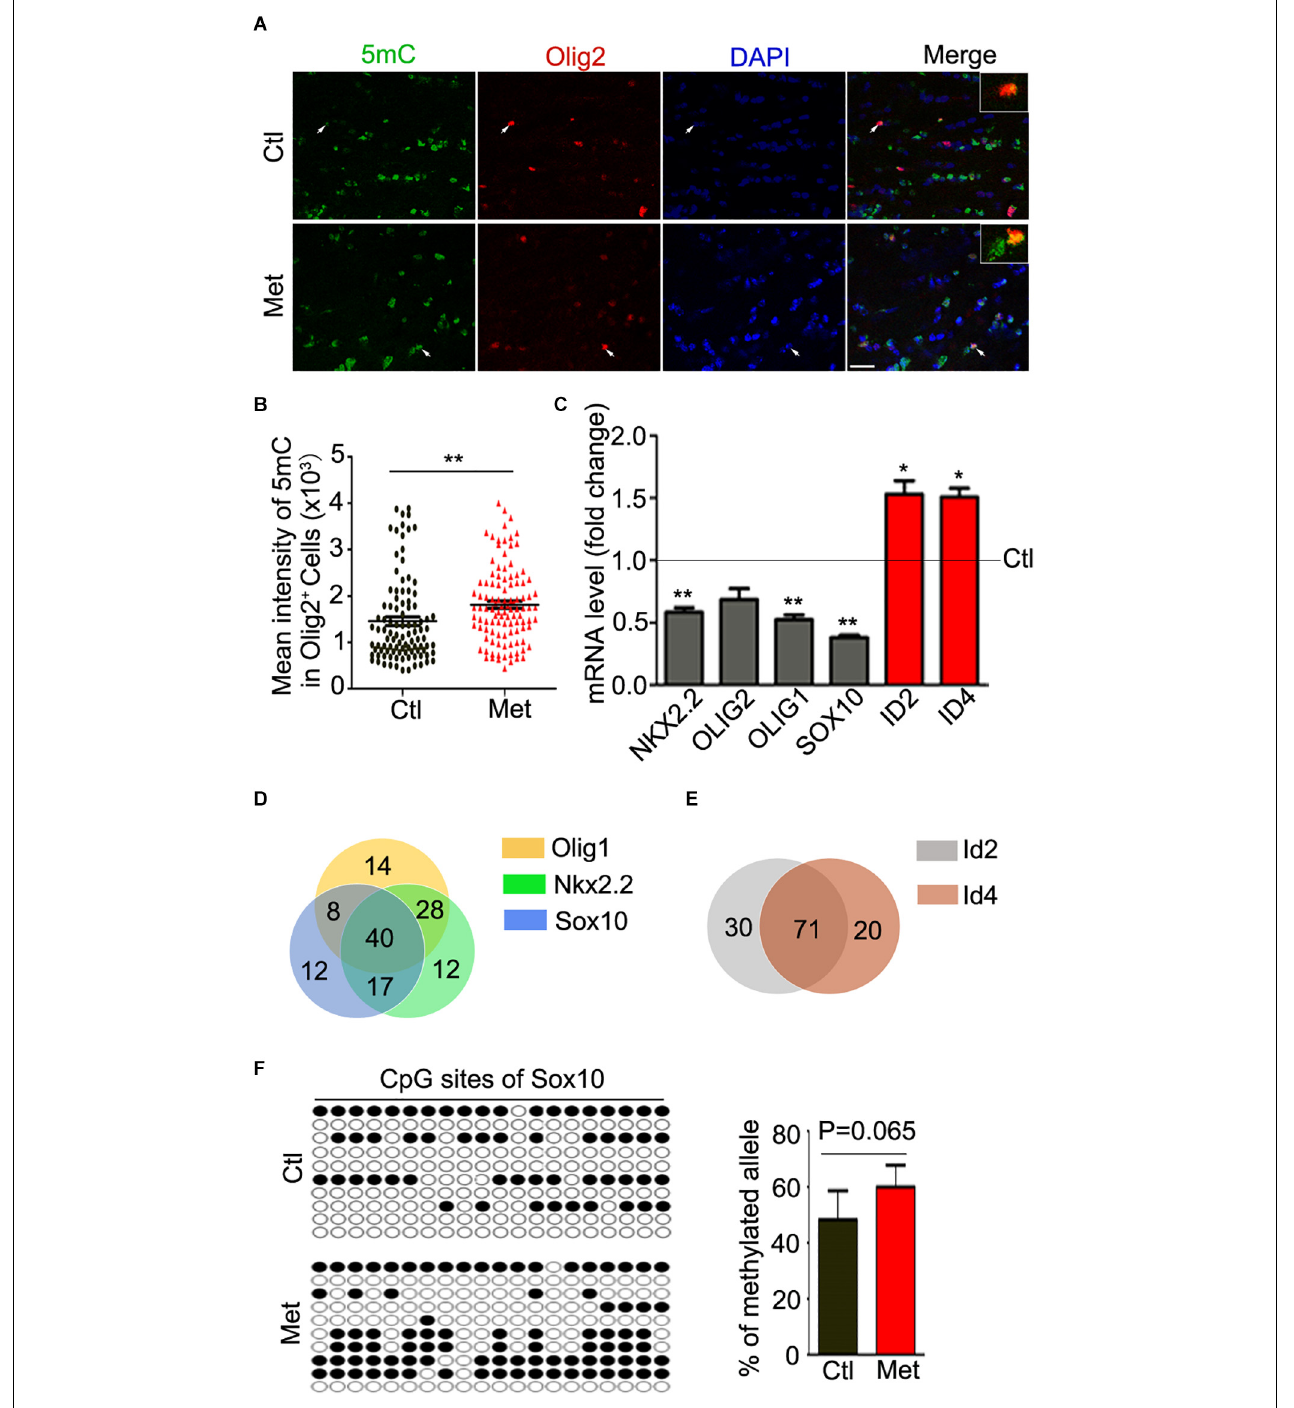
FIGURE 2 | Analysis of 5mC and gene expression in oligodendroglial lineage cells after Met treatment. (A) Representative images showing immunofluorescence staining of 5mC and Olig2 in the frontal white matter in mice. Ctl, vehicle-treated mice. Met, Met-treated mice. White arrows indicate representative 5 mC and Olig2 duoble-labling cells, which are enlarged in white rectangle. Scale bar = 20 µ m. (B) The bar graph shows the quantification of the mean intensity of 5mC in Olig2-staining cells ( n = 100 cells from 5 mice in the Ctl group, n = 109 cells from 5 mice in the Met group). (C) The graph shows the quantification of NKX2.2, OLIG2, OLIG1, SOX10, ID2, and ID4 transcript levels in the frontal white matter in Met mice, which were normalized to the transcript levels in Ctl mice (dashed line) ( n = 3 for each group). (D) The venn diagram shows the number of transcription factors predicted to bind to the promoters of Olig1 (yellow), Sox10 (blue), and Nkx2.2 (green). (E) The venn diagram shows the number of transcription factors predicted to bind to the promoters of Id2 (gray) and Id4 (red). (F) The dot diagram shows the methylated sites (solid points) in predicted CpG island of Sox10 promoter in Ctl and Met group. The right bar graph shows the quantification of the methylated alleles ( n = 3 for each group). The data are expressed as the mean ± SEM. * P < 0.05; ** P < 0.01.